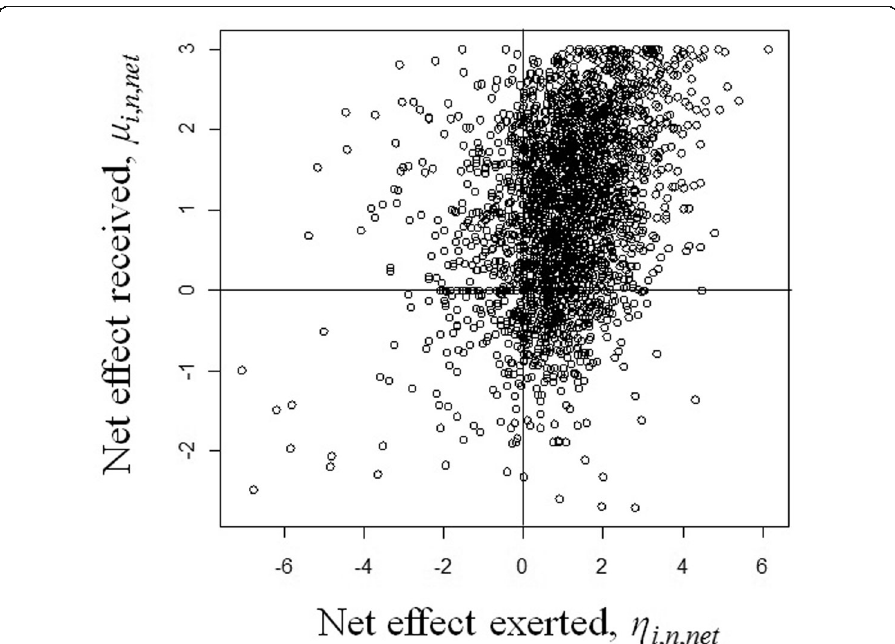
Fig. 7 A scatter plot of net effects exerted ( η i , n , net ) and received ( μ i , n , net ) by individual students after pooling all results together from our analysis on the Hungarian high school